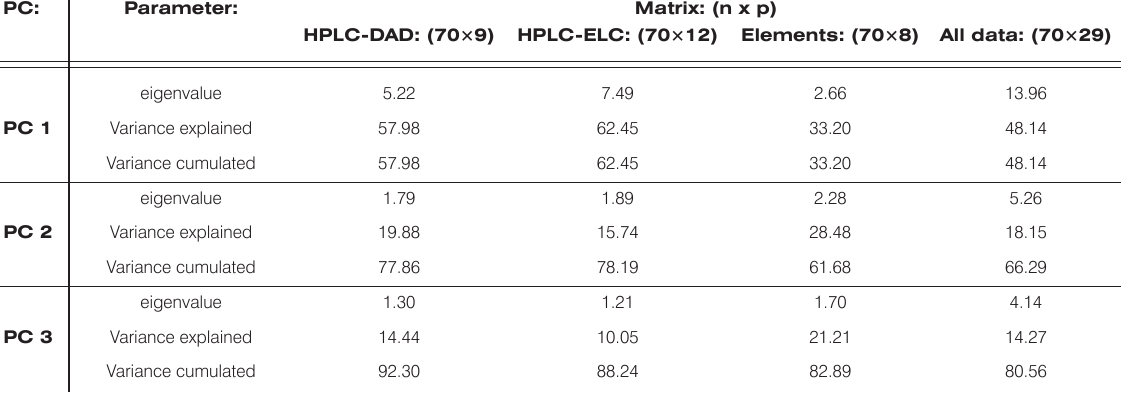
Table 2. Results of PCA calculations obtained for first 3 principal components: n = objects; p = variables.